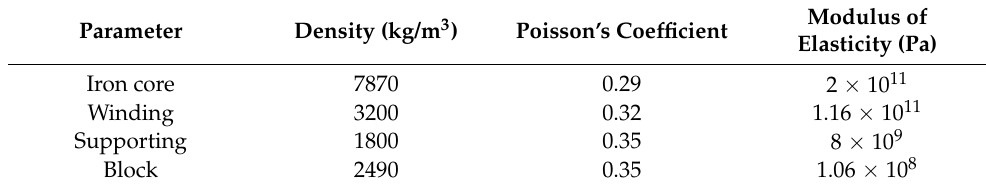
Figure 3. External circuit diagram. Table 2. Transformer mechanical parameters.